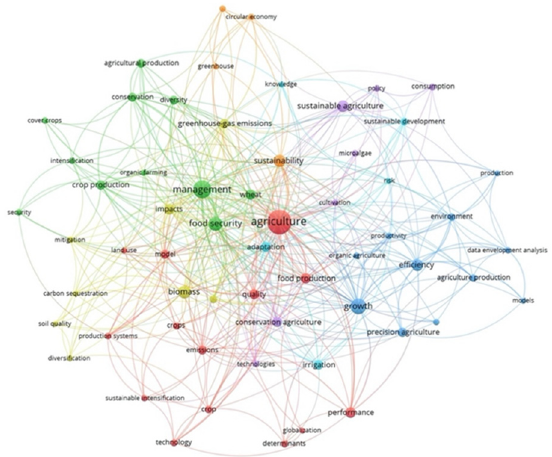
Figure 1. The bibliometric keywords analysis of agricultural production dimension, considering Web of Science (WOS) publications during the years 2017–2022. Source: Elaborated by the authors using VOSviewer software.